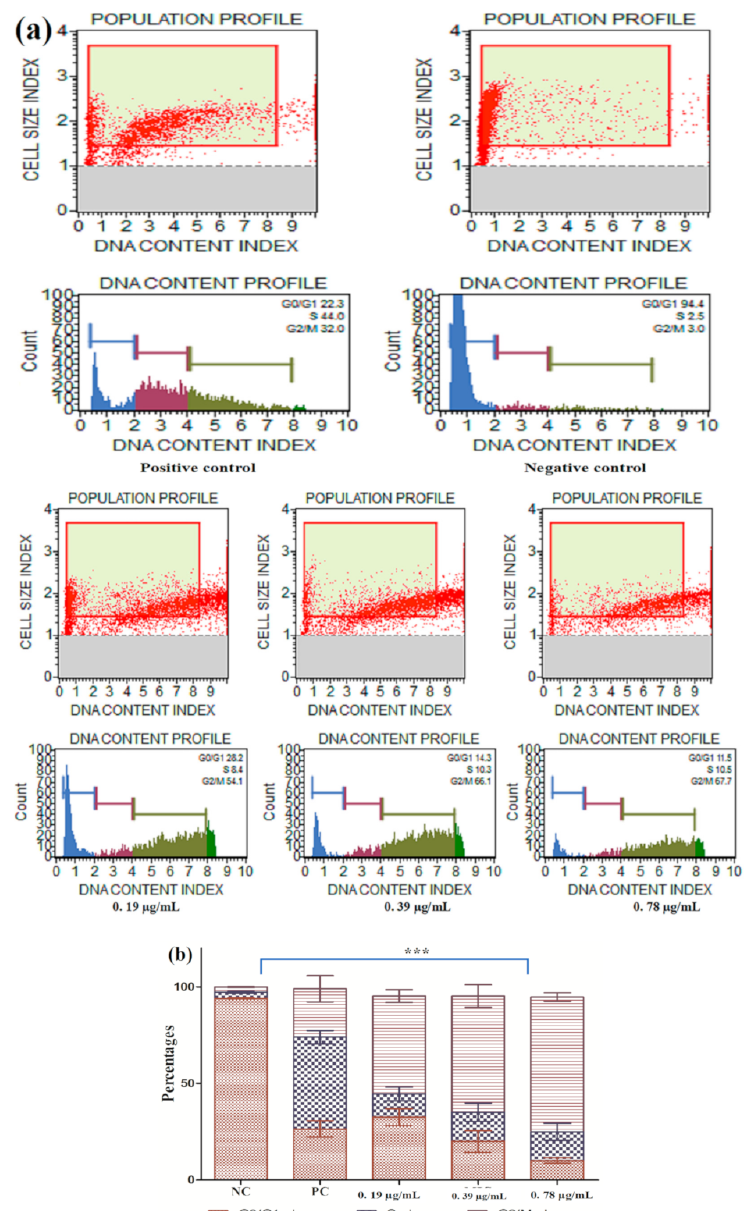
Figure 9. Analysis of cell cycle arrest in C. auris . ( a ) Representative images of cell cycle progression and cell size index in C. auris MRL6057 after exposure to 1 / 2 MIC, MIC and MFC values of the Ag–Fe NPs. Cells exposed to H 2 O 2 were the positive control (PC), whereas untreated cells were the negative control (NC). ( b ) Average values were obtained for exposed and unexposed C. auris cell cycles, representing the effects of Ag–Fe NPs on different stages of cell cycle. *** p ≤